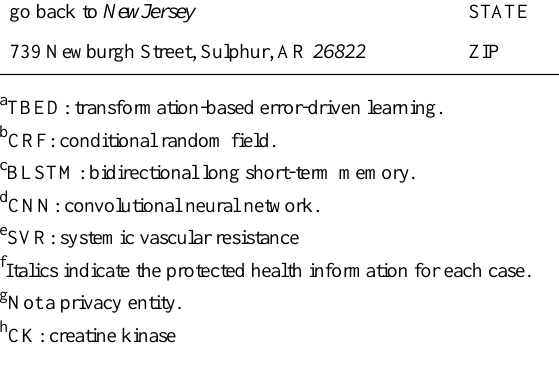
Change, %F1-measure, %Model